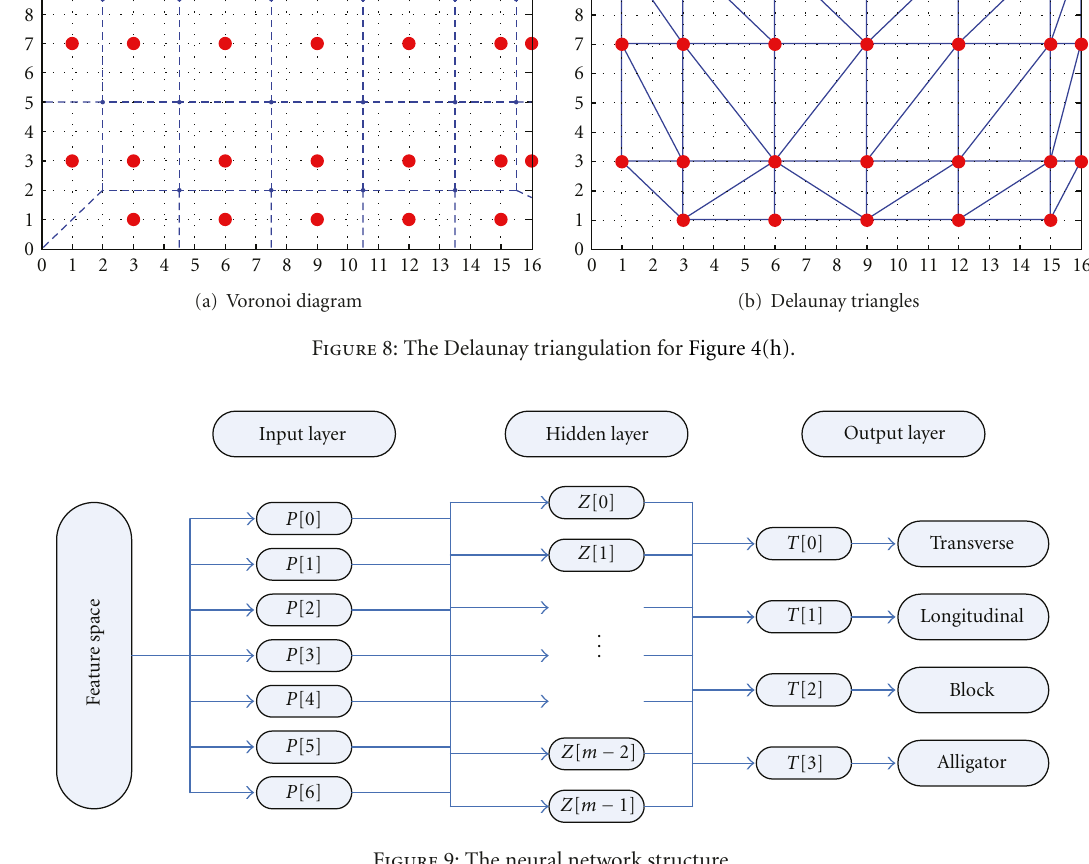
Figure 9: The neural network structure.